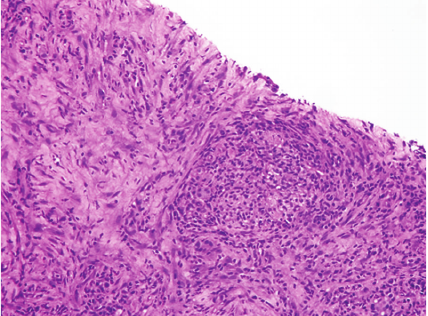
Figure 4: Liver biopsy. Cholestasis with multiple large areas of necrosis palisaded by epitheloid cells with associated granulomatous inflammation.